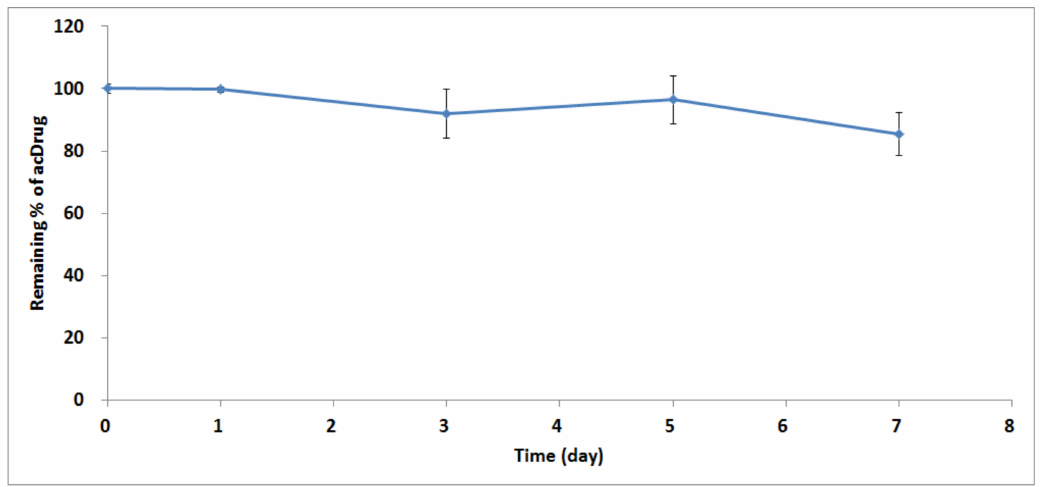
Figure 4. In vitro linker stability of acDrug in LCB14-0110 ADC in rat